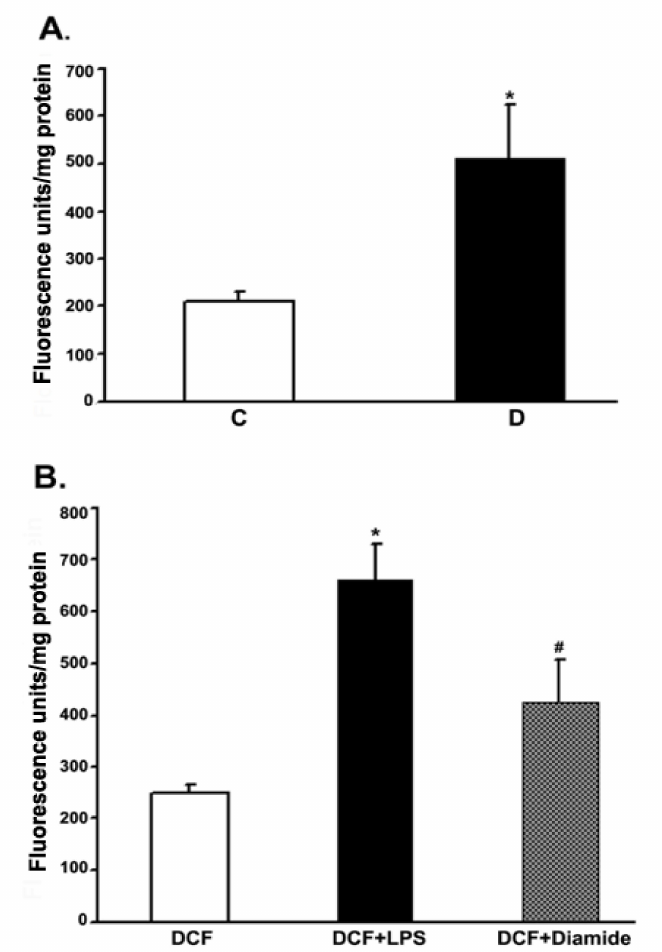
Figure 6. Measurement of the ROS levels in rat retinas under in vivo conditions. Rats were intrav- itreally injected with either CM-H 2 DCFDA or LPS or diamide as described in the method section. The extent of the oxidized fluorescence and retinal protein were measured in each excised retina, which is presented as fluorescence units/mg of retinal protein. ( A ). Control (C) vs. diabetic